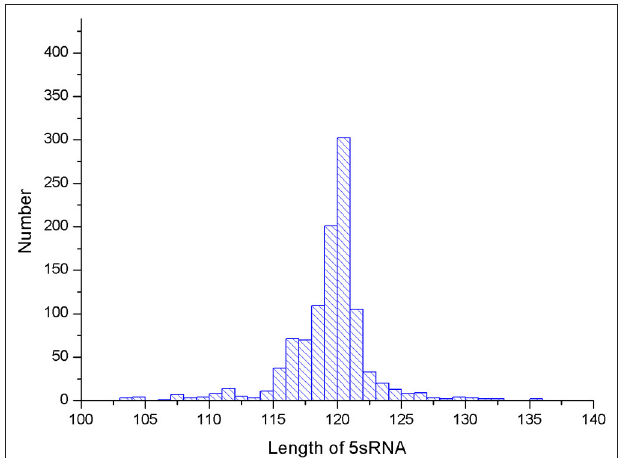
FIGURE 4 | 5sRNA length distribution.